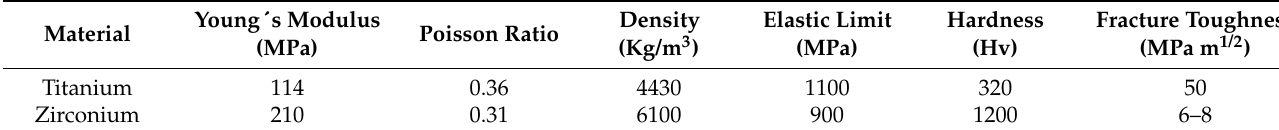
Table 2. Mechanical properties of titanium and zirconium.